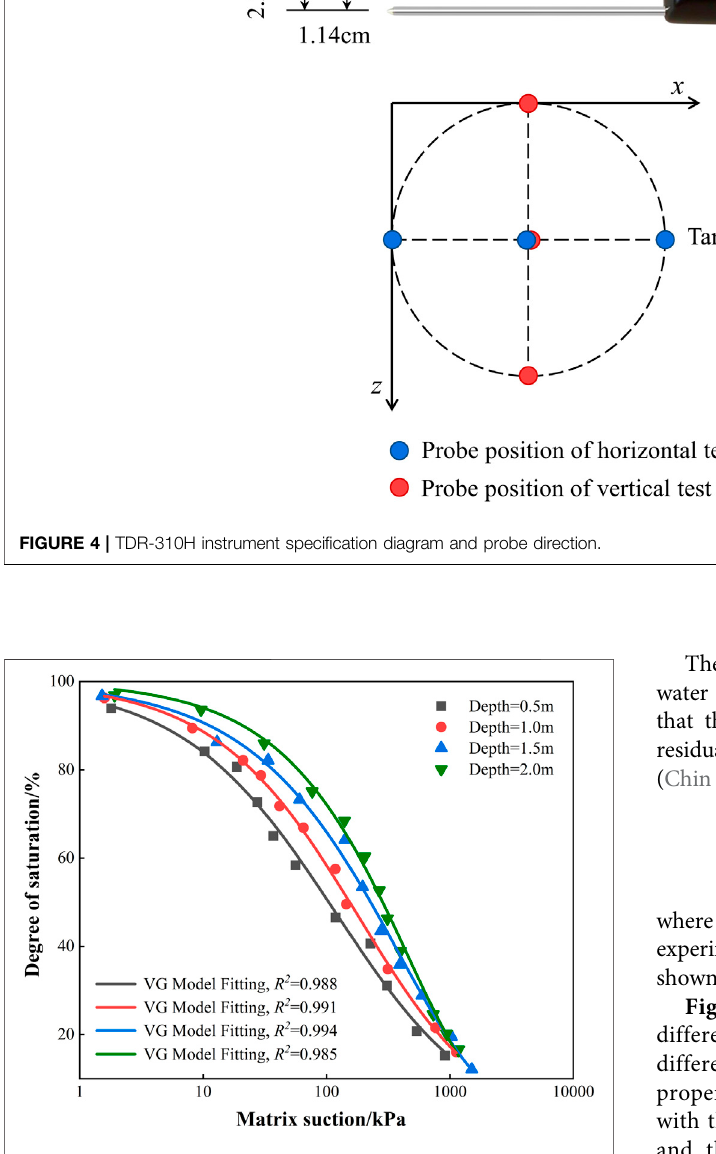
Frontiers in Earth Science |